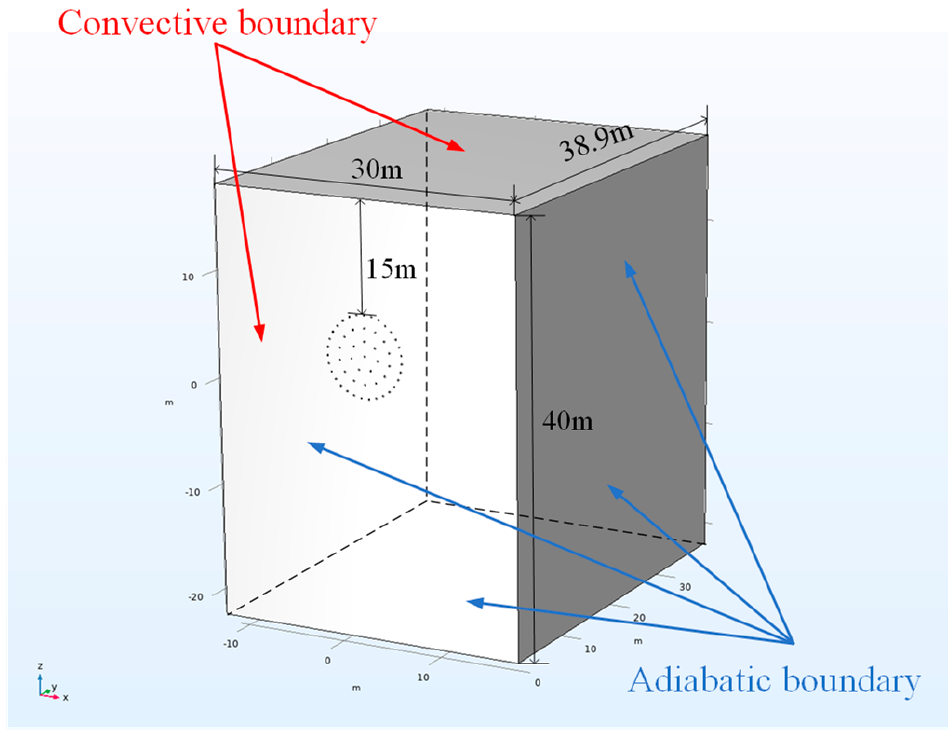
Figure 3. Model diagram.